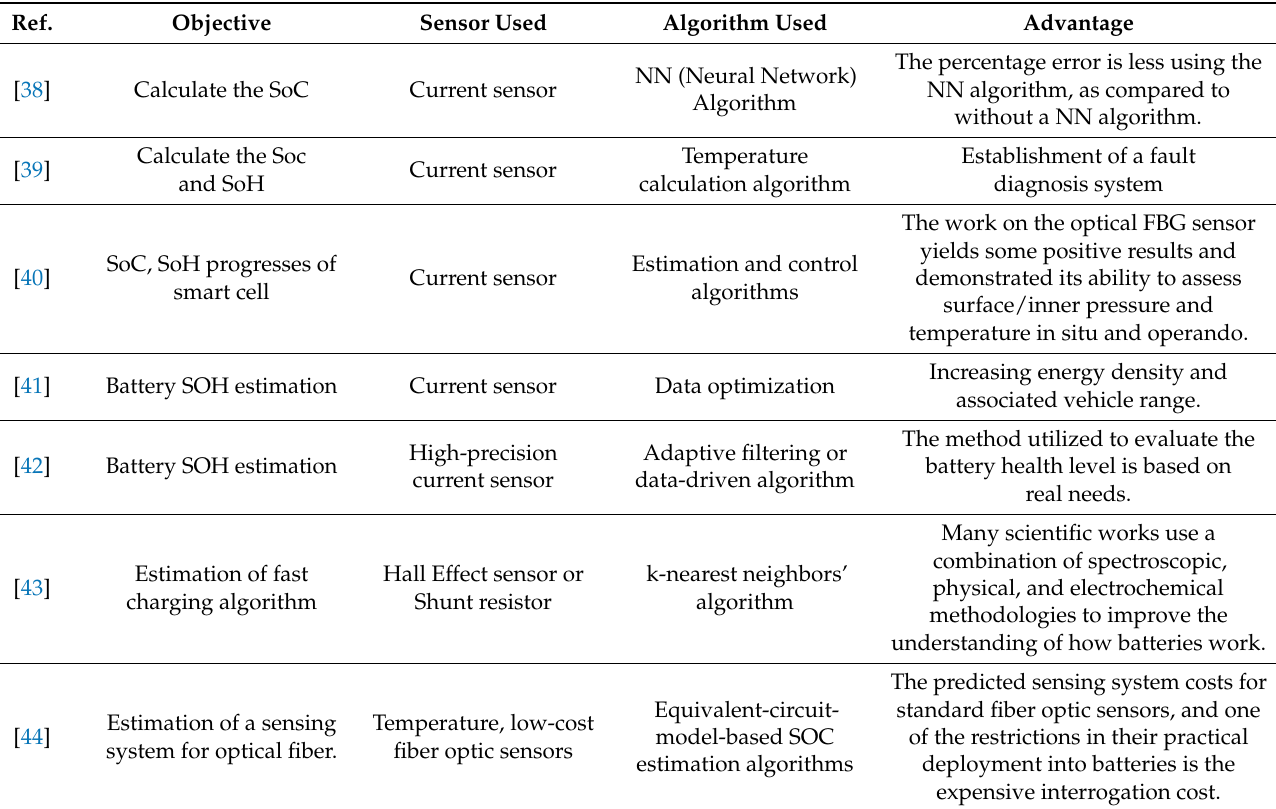
Table 3. A detailed survey of IoT in battery-management